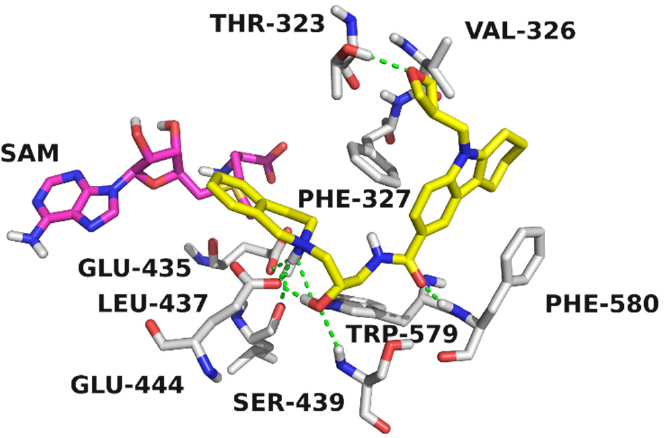
Figure 3. Compound 20 docked into X-ray structure of PRMT5 (PDB code:4X61). Figure 3. compound 20 docked into X-ray structure of PRMT5 (PDB code:4X61). MV-4-11 and MDA-MB-468 cell lines were used to evaluate the anti-proliferative activities of the selected target compounds (CellTiter-Glo assay), and AML-12 hepatocytes were selected to evaluate the toxicity of the compounds. As shown in Table 3, compound 20 exhibits stronger anti-proliferative activities than GSK-3326595 in MV-4-11 and MDA-MB- 468 cell lines. however, it has almost no toxicity compared to normal AML-12 hepatocytes. Table 3. Anti-proliferative activity of compounds in